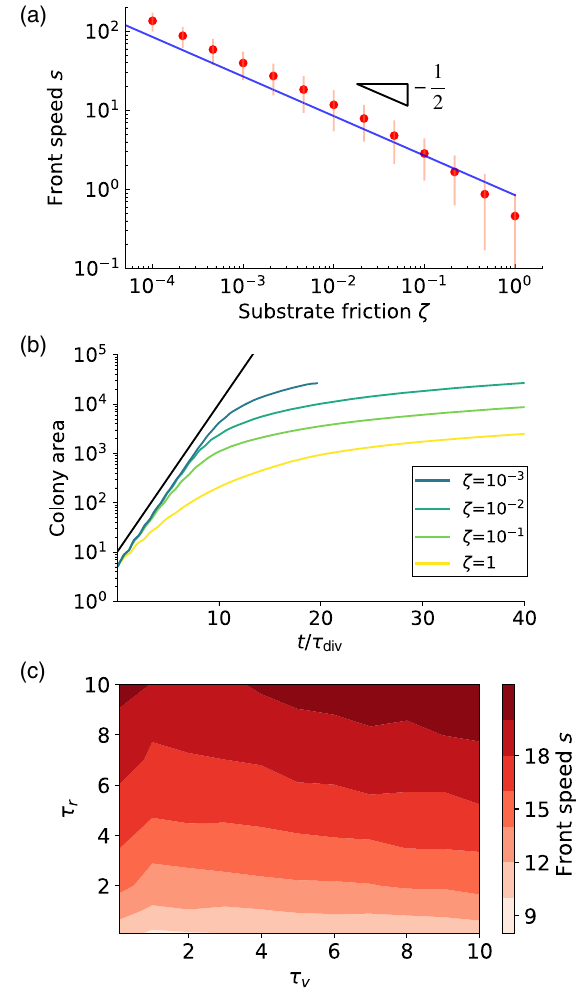
FIG. 3. The front speed of an expanding colony scales like the inverse square root of the substrate friction. (a) The dimensionless front speed s is shown as a function of dimensionless substrate friction ζ : Red points, and one standard-deviation error bars, are from particle-based simulations, see Appendix A for details, while the solid blue line is from the continuum theory via numerical solution of Eqs. (14) – (17) subject to boundary con- ditions (18). (b) The dimensionless colony area first grows exponentially (solid black line shows exponential trend) becom- ing linear in time after steady growth fronts emerge. Each line represents the mean value of 5 independent simulations under each ζ condition. (c) At fixed surface friction ζ ¼ 0 . 01 the front speed also depends on the dimensionless characteristic cell-cycle times τ and, to a lesser extent, τ r v